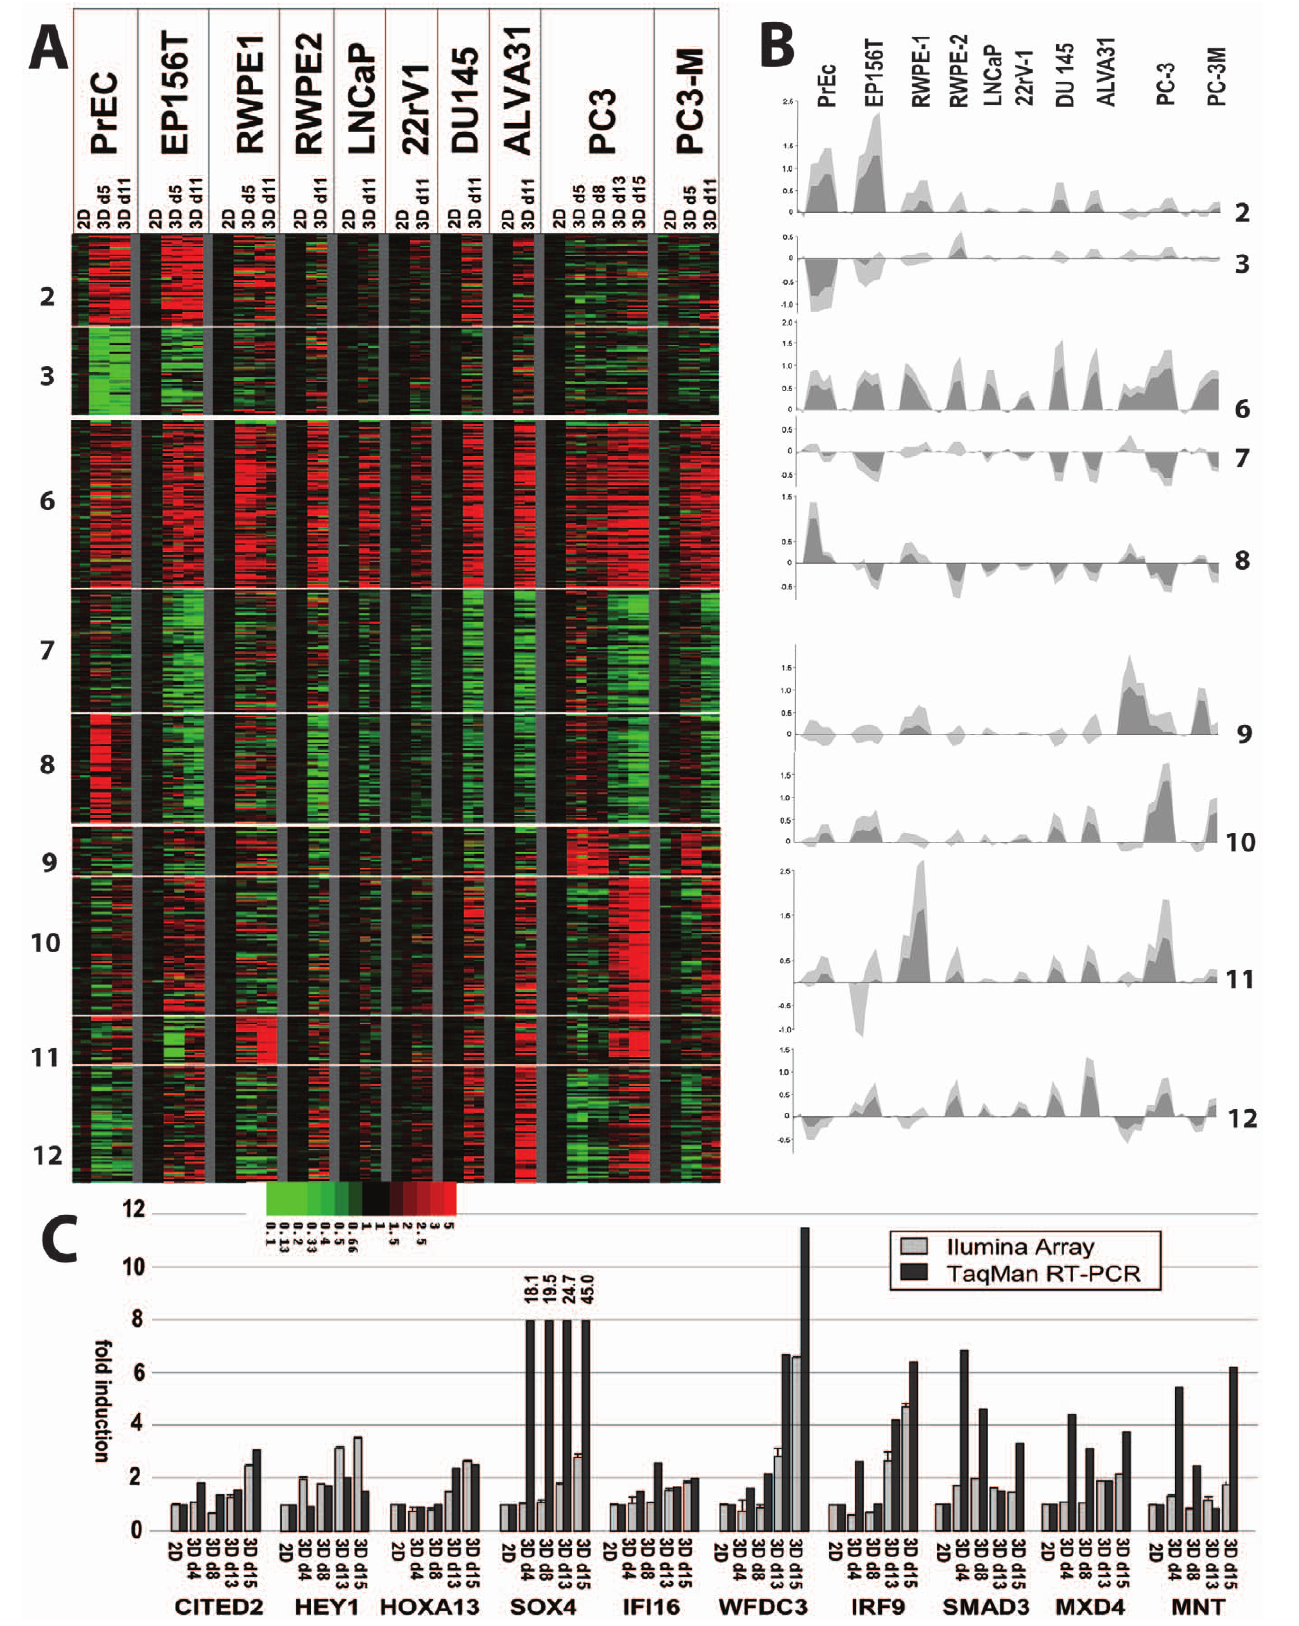
Figure 4. Characteristic patterns of altered mRNA gene expression of cells cultured in laminin-rich ECM (Matrigel), compared to monolayer culture (ratios 3D/2D). A) Heatmap, illustrating 12 clusters generated by the K-means algorithm. Clusters 1 + 2 represent genes